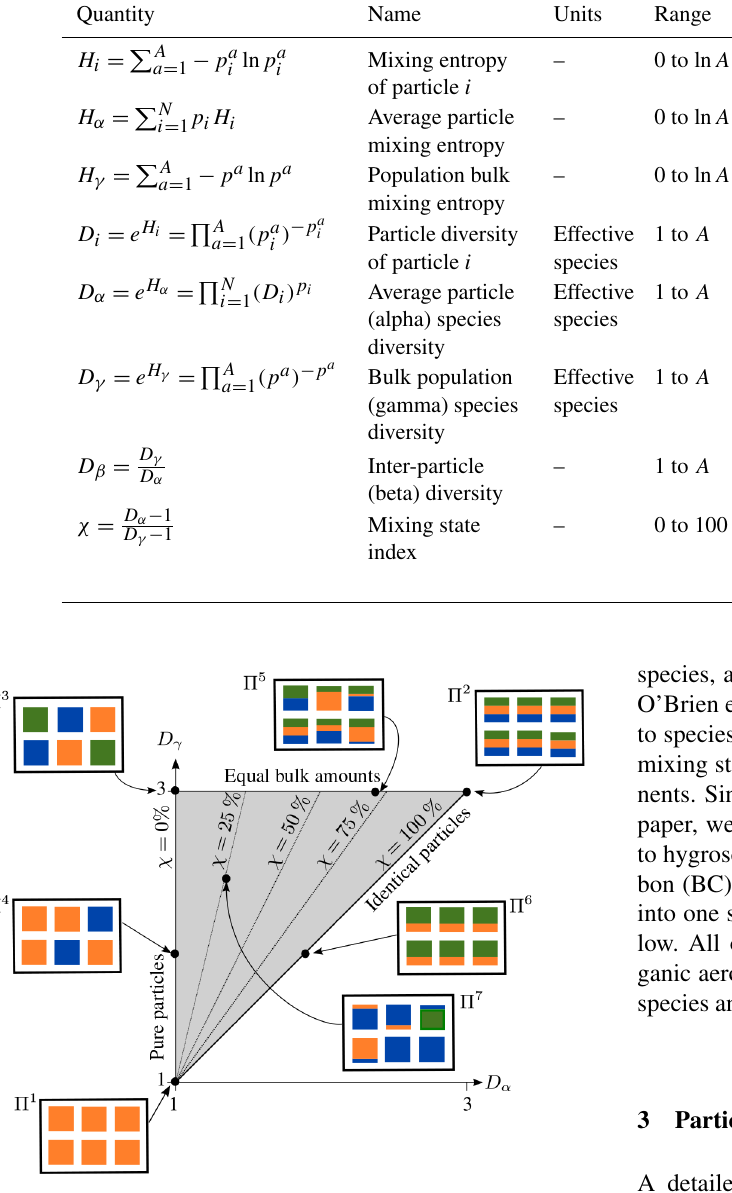
Figure 1. Mixing state diagram to illustrate the relationship be- tween average particle diversity D α , bulk population diversity D γ , and mixing state index χ for seven example populations ( (cid:53) 1 to (cid:53) 7 ). Each population consists of six particles, and the colors rep- resent different chemical species ( A = 3). This figure is taken from Riemer and West